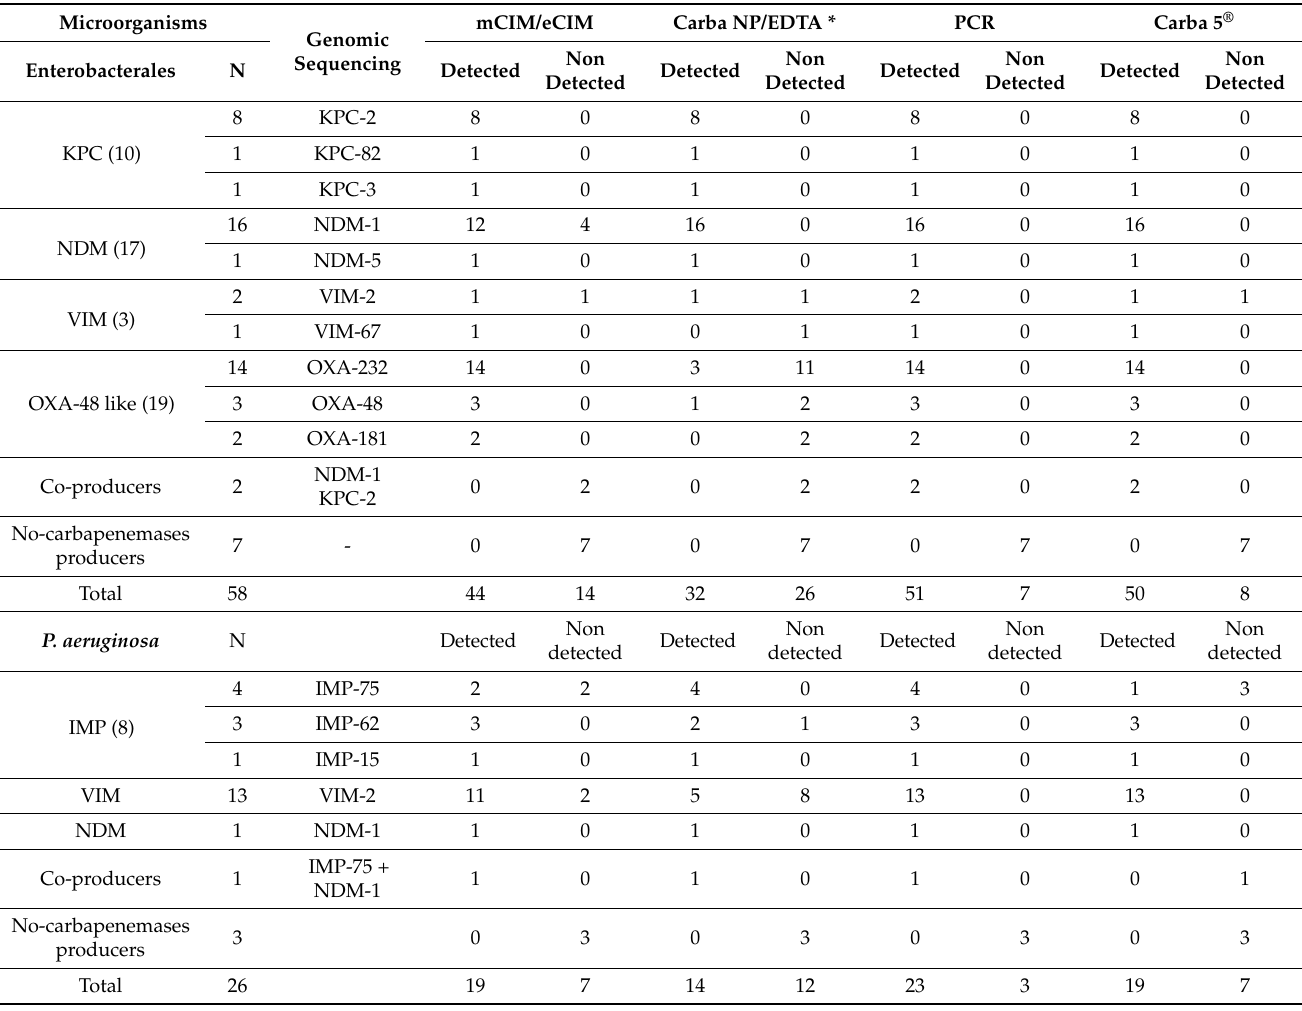
Table 2. Performance of phenotypic assays, NG-Test CARBA 5 ® , and PCR for Enterobacterales and P. aeruginosa